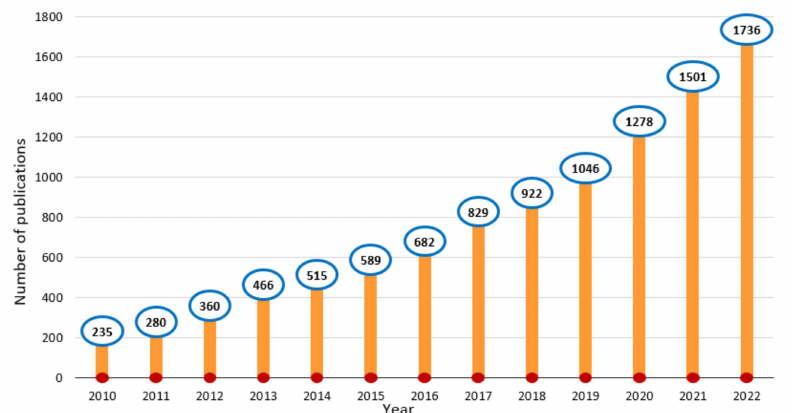
Figure 2. FO publications growth since 2010. The information was obtained from Science Direct using “forward osmosis” as a